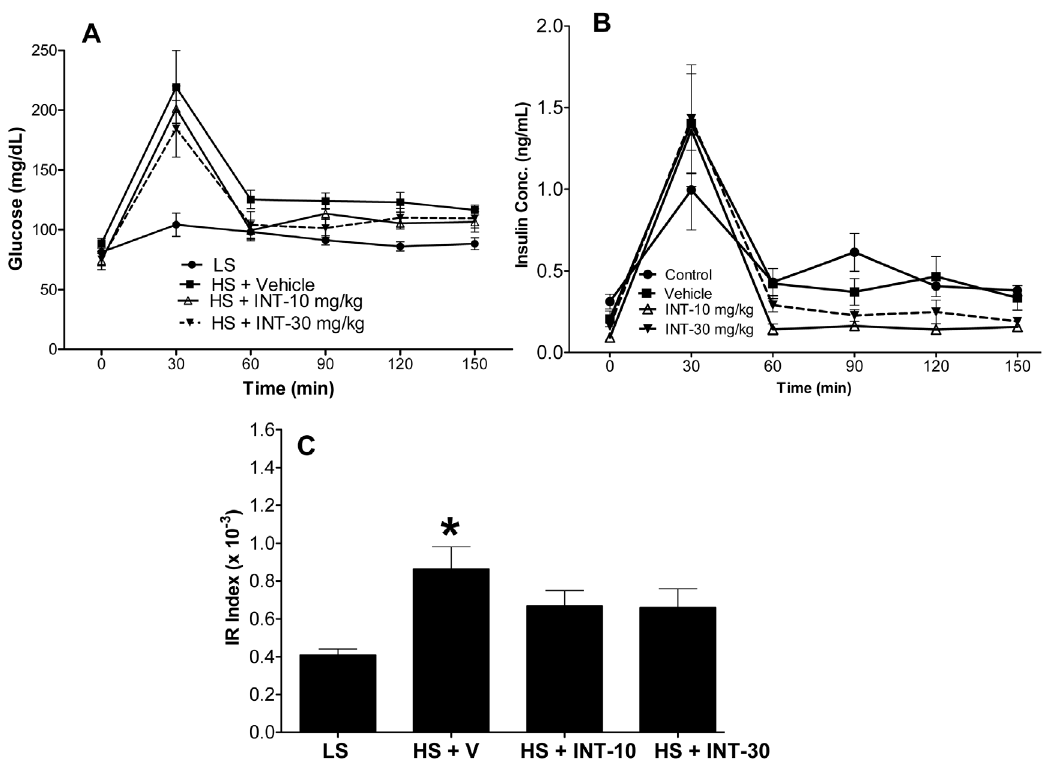
Figure 6. Blood glucose and insulin measurements to assess insulin sensitivity: Measurement of a) blood glucose \and b) plasma insulin concentration over time during GTT in Dahl rats fed with low or high-salt diet for 5-weeks prior to the glucose challenge test. Values are Mean 6 SEM for: Control (n =6); Vehicle (n =7); INT-10 mg/kg/day (n =5) and INT-30 mg/kg/day (n=9). *p , 0.05 versus high-salt diet data. ANOVA followed by Bonferroni post-test. GTT=glucose tolerance test. In c), the effect of INT-747 treatment on insulin sensitivity is shown. Insulin Resistance (IR) index was calculated as described in the text. Data is expressed as Mean 6 SEM. (*p , 0.05 versus low-salt diet data. ANOVA followed by Bonferroni post-test). LS=low salt; HS=high salt; V=vehicle; INT-10=INT-747 at 10 mg/kg/day and INT-30=INT-747 at 30